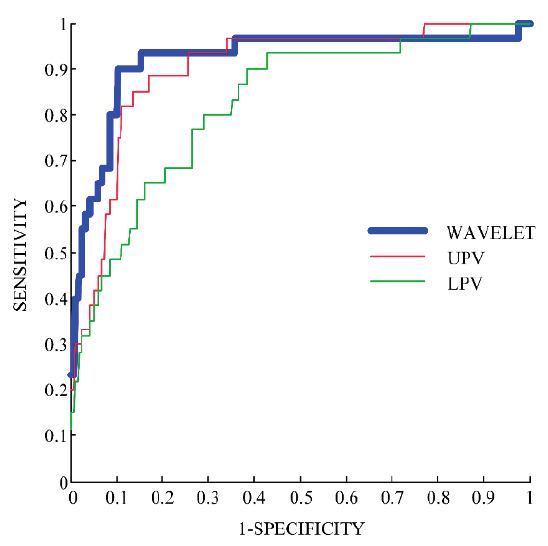
Figure 3. ROC curve of three features: the Wavelet-based (in blue), the Upper Peak Value (UPV, in red), and the Lower Peak Value (LPV, in